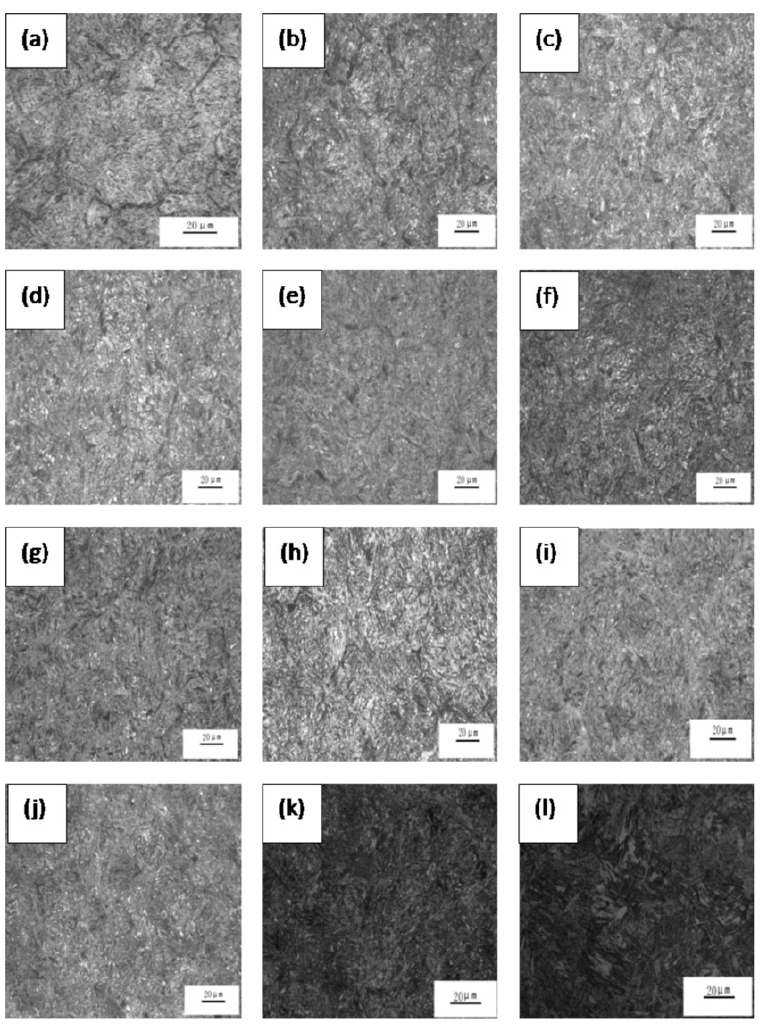
Figure 16. The metallograph layer by layer: ( a ) case, ( b ) depth of 20 µ m, ( c ) depth of 40 µ m, ( d ) depth of 60 µ m, ( e ) depth of 80 µ m, ( f ) depth of 100 µ m, ( g ) depth of 120 µ m, ( h ) depth of 160 µ m, ( i ) depth of 180 µ m, ( j ) depth of 200 µ m, ( k ) depth of 600 µ m, and ( l ) core.